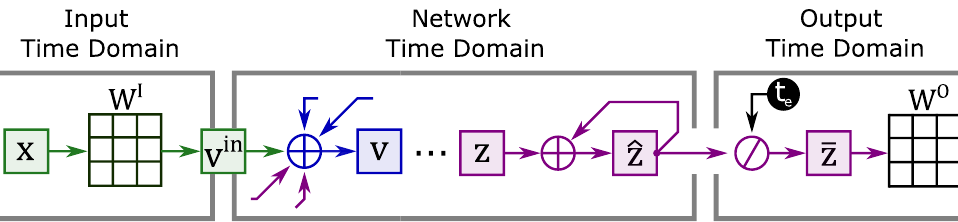
Figure 7. Flowchart modified to handle current-driven input. In this application scenario the input and output have two different time domains from the network. v in and ˆ z vectors are used to pass information from the input to the network and from the network to the